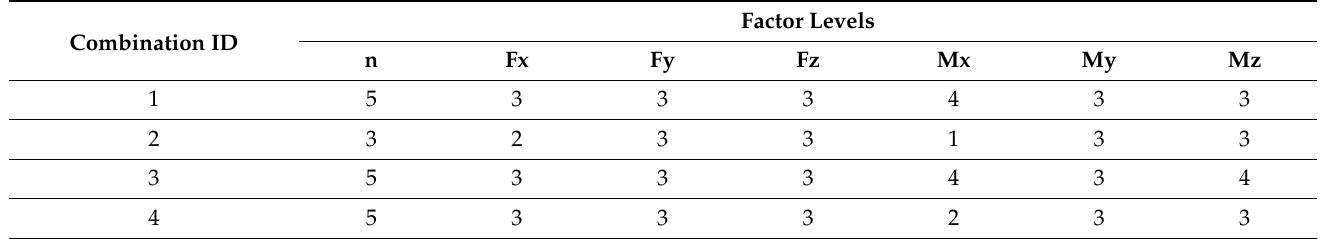
Table 8. Most frequent factor level combinations collectively accounting for 80% of available data.